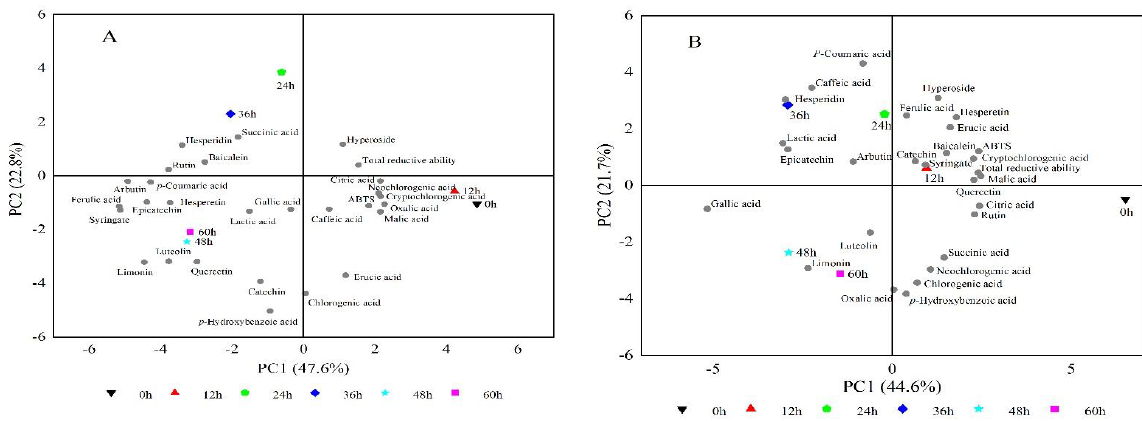
Figure 4. Principal component analysis (PCA) of the properties of fermented ( A ) and control ( B ) lemon juice.